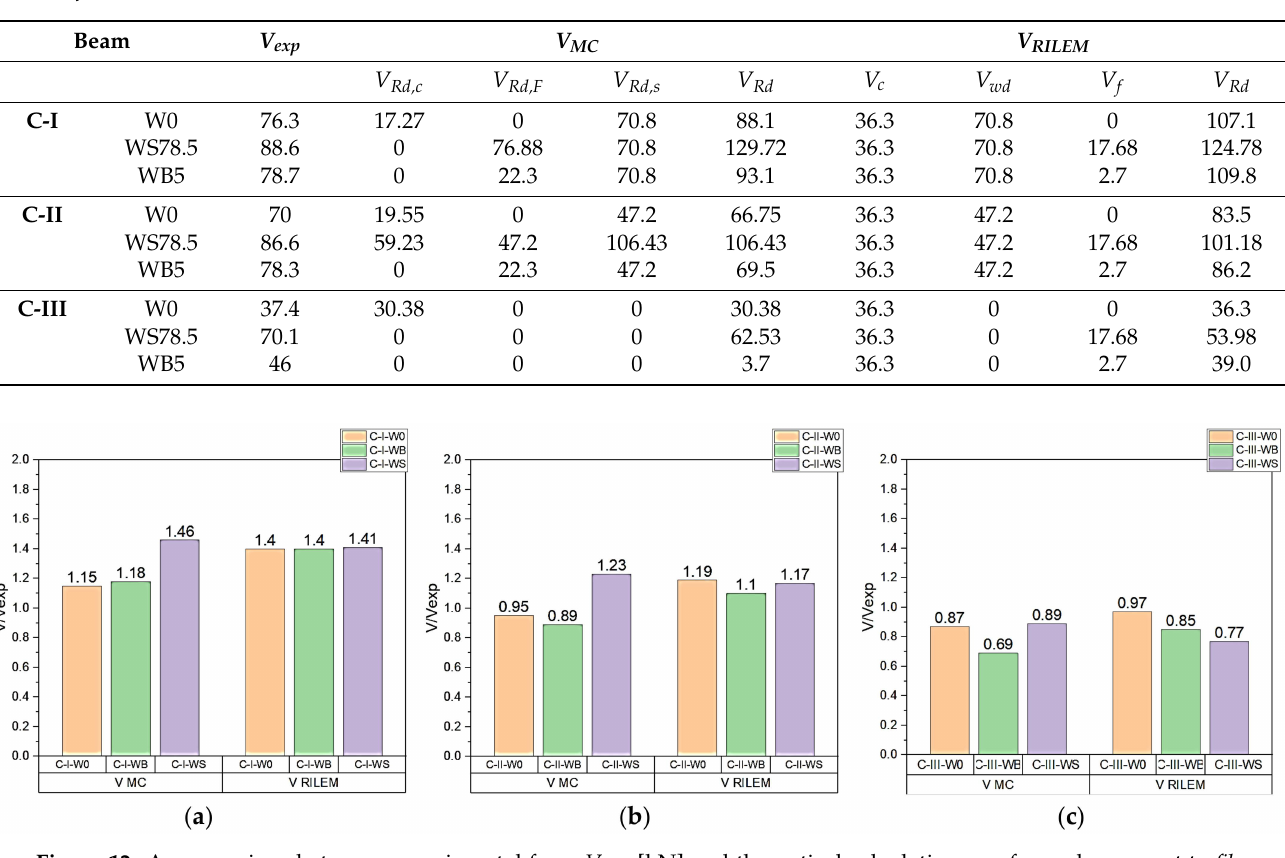
Table 4. Comparison of the Values of Shear Capacity Obtained from Experimental Result ( V Exp ) and from RILEM ( V RILEM ) and fib Model Code ( V MC ) Calculations of the Tested Beams.